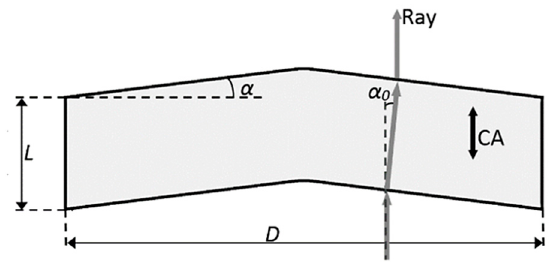
Figure 1. Longitudinal section through the mode converter.